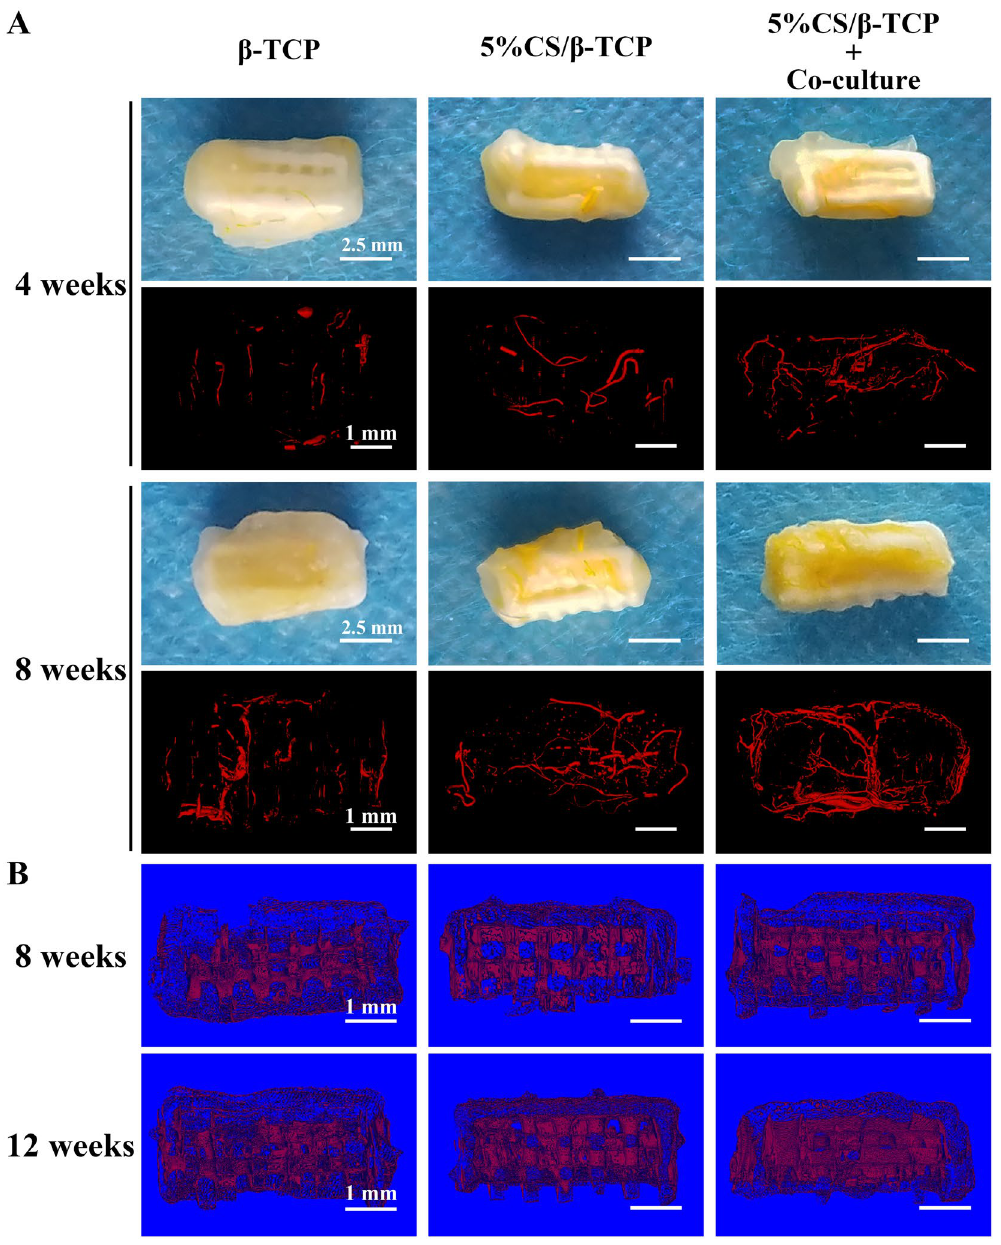
Figure 7. Analysis of new vessels and new tissue. ( A ) Macroscopic and micro-CT imaging of new vessels formed at 4 and 8 weeks in β -TCP and 5%CS/ β -TCP scaffolds, as well as in 5%CS/ β -TCP scaffolds seeded with co-culture cells. ( B ) Micro-CT analysis of new tissues formed in scaffolds at 8 and 12 weeks. Scale bar represents 2.5 mm for macroscopic and 1 mm for